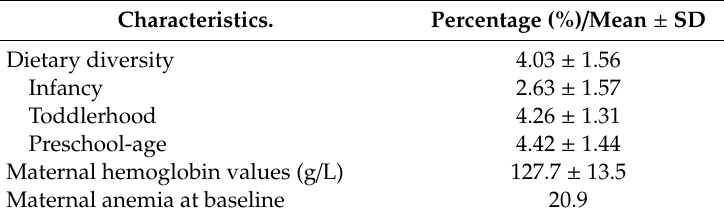
Table A1. Descriptive statistics for the dietary diversity and maternal anemia status of sample children.